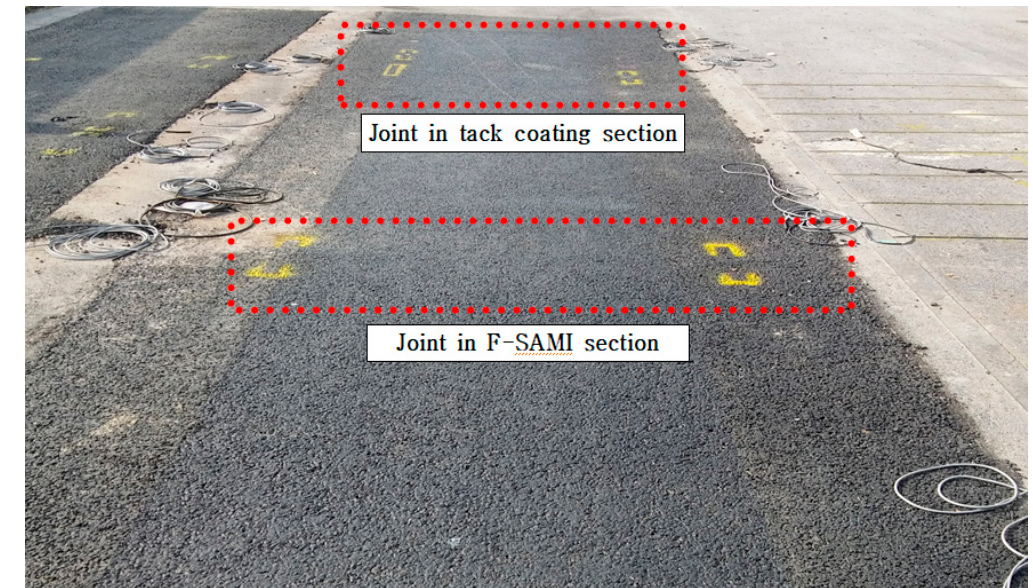
Figure 10. Crack occurring area (top of the joint).